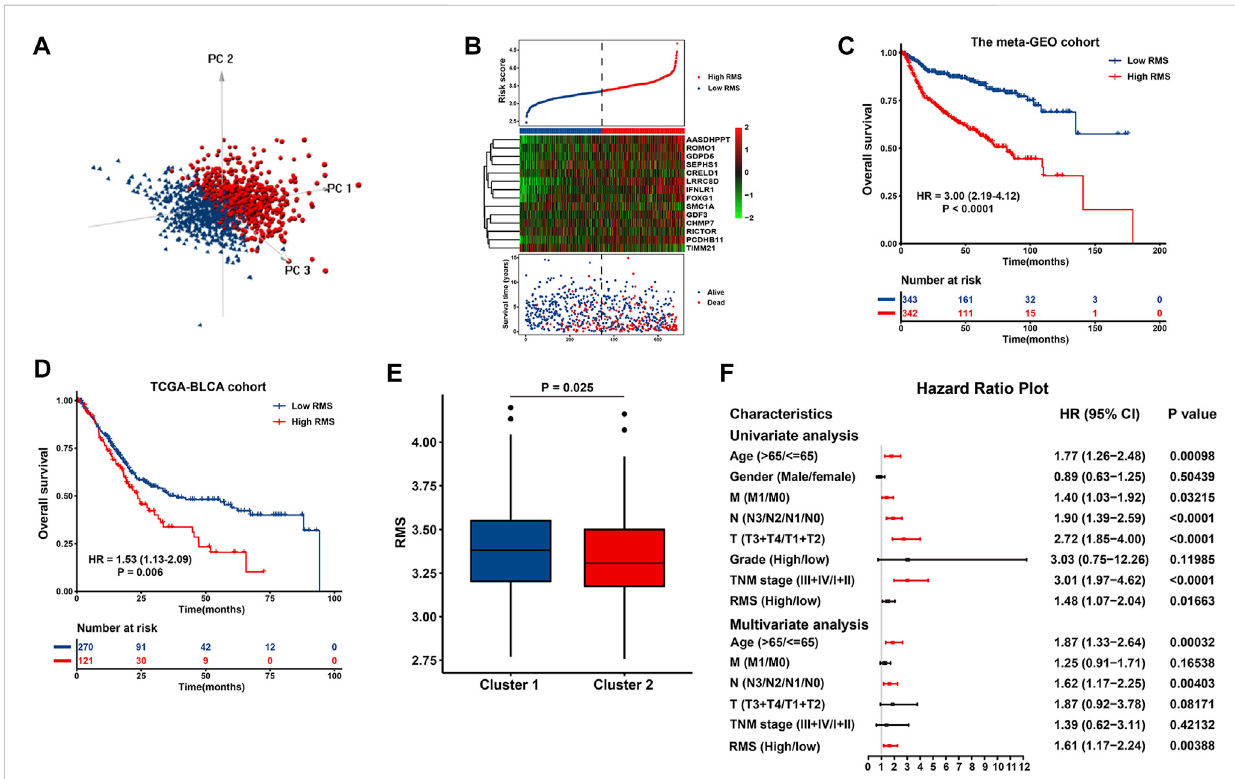
FIGURE 6 ConstructionandevaluationoftheRMSmodelinBCa. (A) PCAexhibitingaremarkable distinction betweencaseswithhighorlowriskscore. (B) The risk score distribution, heatmap showing the expression of 14 DEGs, and survival status for each BCa case in the meta-GEO group. The black dotted line indicatedtheRMScutofftoclassifycasesintolow-andhigh-riskgroups.Kaplan-MeiercurverevealingOSdifferencebetweenRMS-highor-lowpatients in (C) theTCGAand (D) meta-GEOgroup. (E) BoxplotsdescribingtheRMSoftwoRNAmodi fi cationpatternsinthemeta-GEOcohort. (F) Forestplot of Cox regression analysis to evaluate the relationship between the RMS and clinicopathological